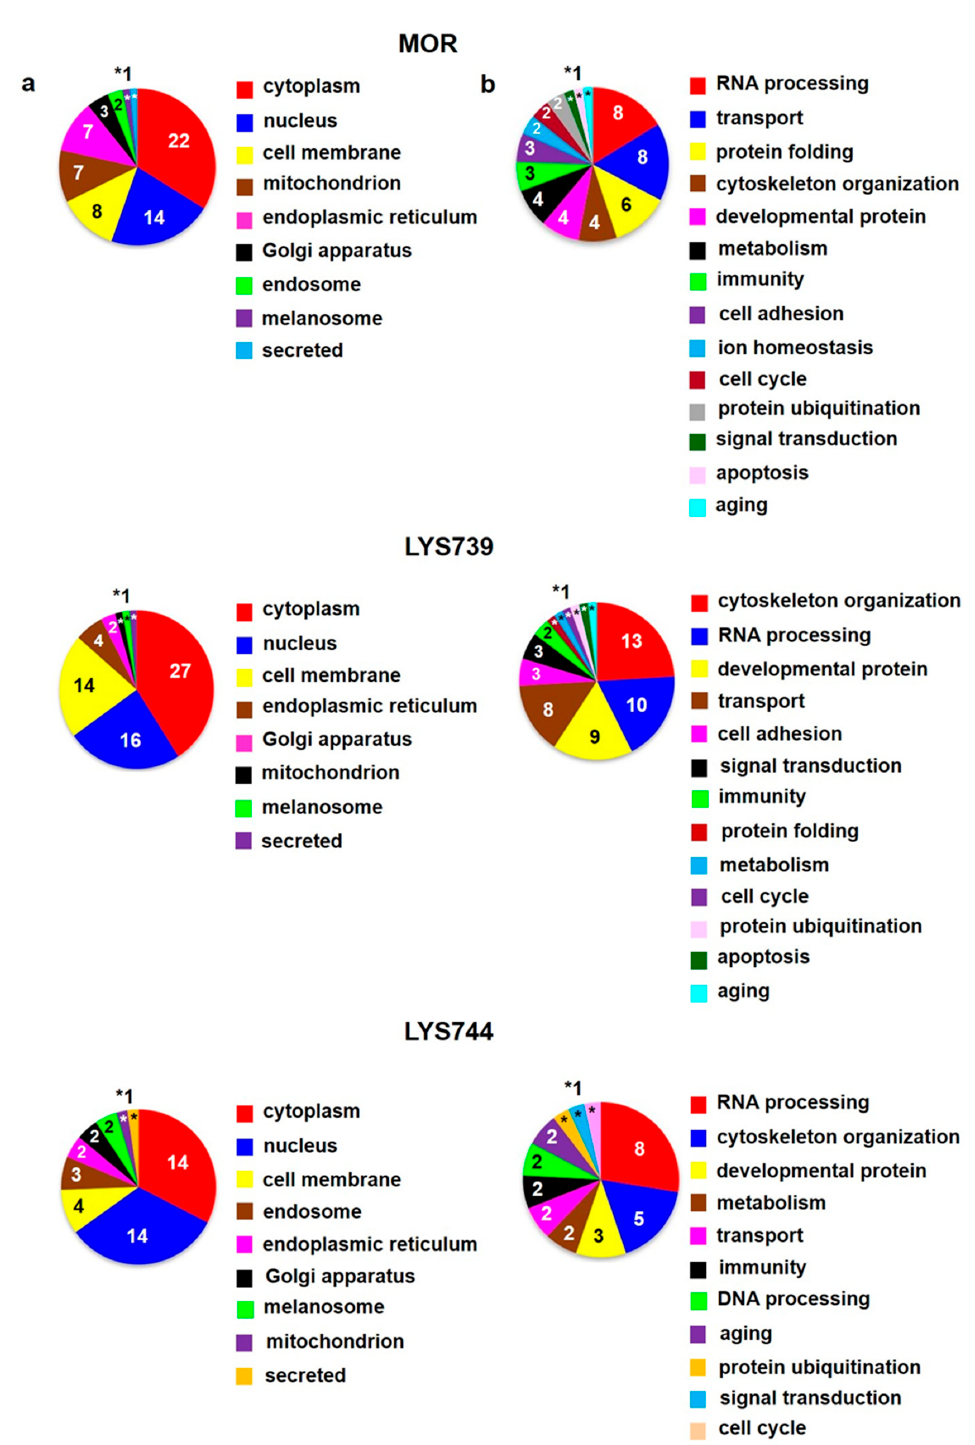
Figure 10. Subcellular localization ( a ) and function ( b ) of significantly altered proteins (at least 2-fold) identified in rat hippocampus after 7-day treatment with 10 mg/kg of morphine ( MOR , upper panels), LYS739 ( middle panels), and LYS744 ( lower panels); according to the current annotations in the Uniprot database (https://www.uniprot.org, accessed on 22 April 2022). The numbers represent proteins found within each subcellular localization and functional category, *1.